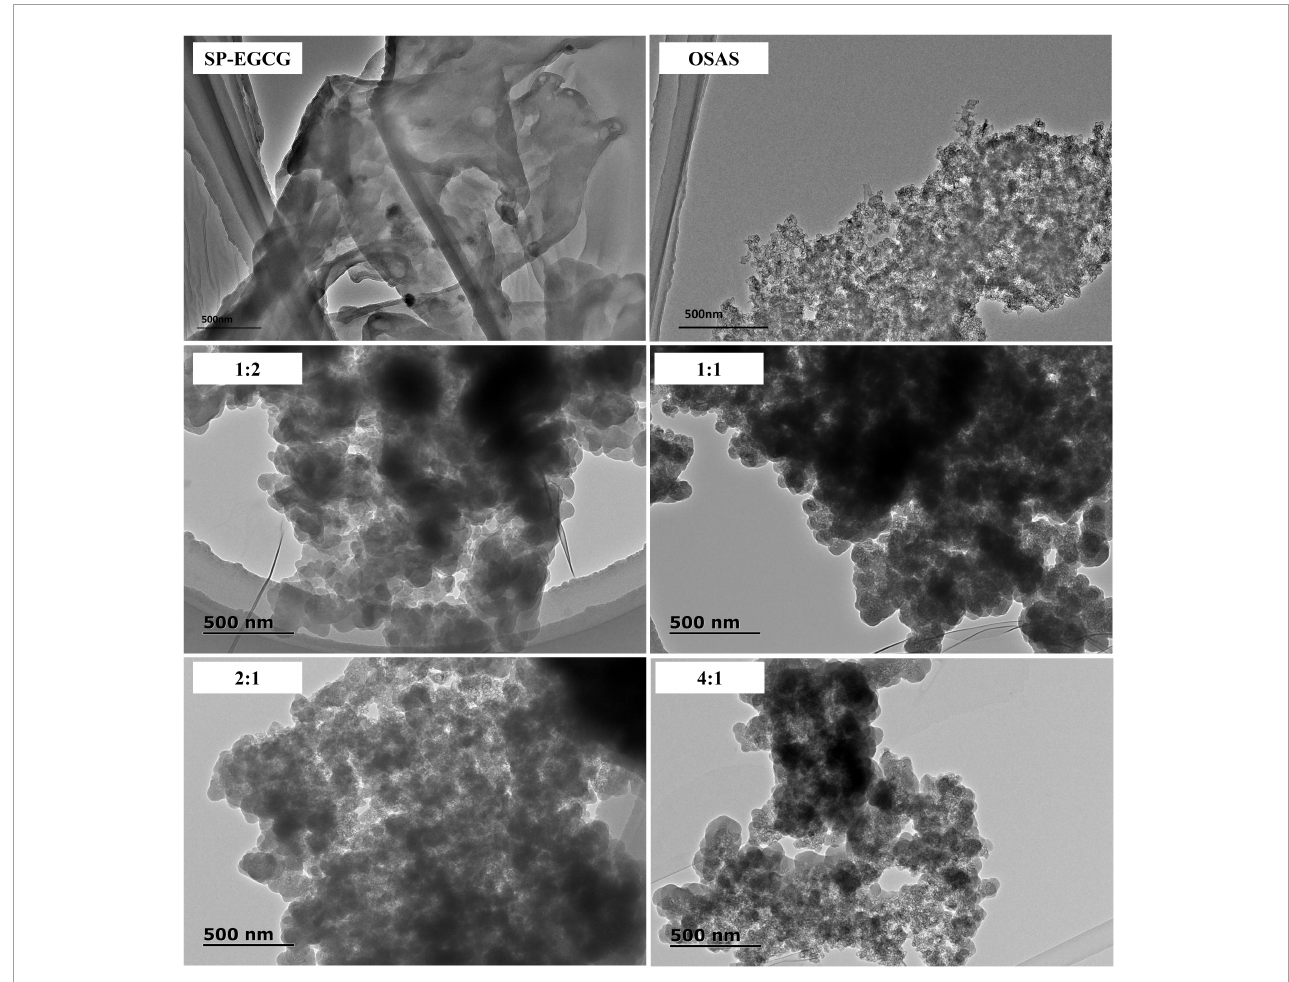
FIGURE6 TEM images for OSAS, SP-EGCG complexes and OSAS-SP-EGCG